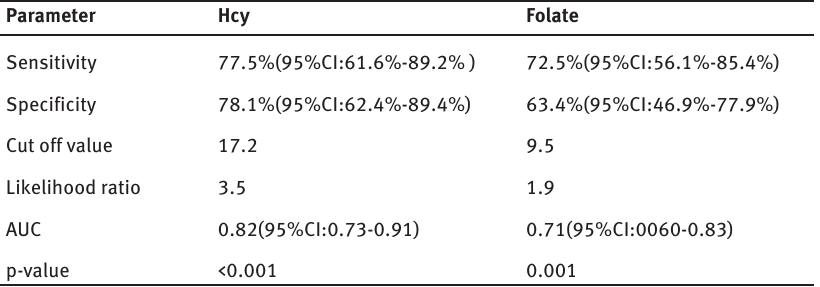
Table 3: The diagnostic performance of serum Hcy and folate as serological marker for cognitive impairment in patients with Parkinson’s